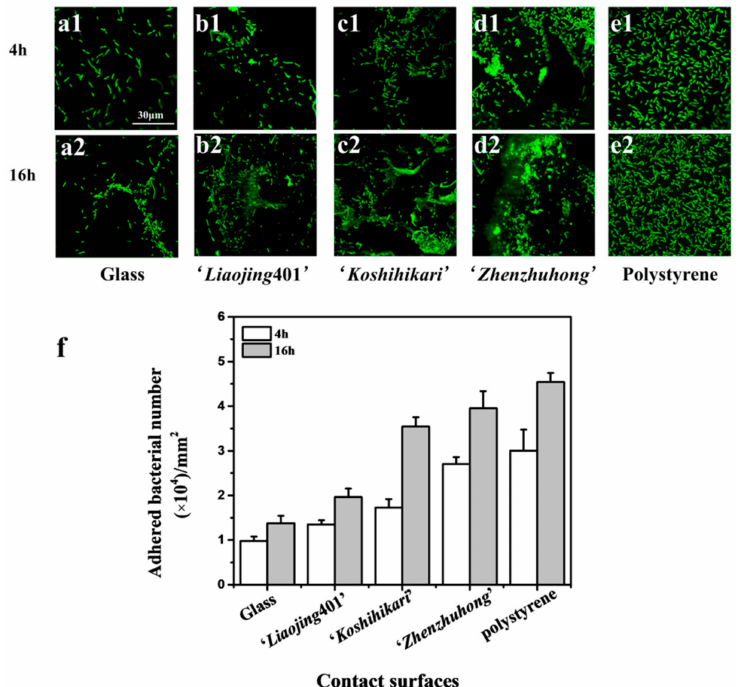
Figure 2. Laser confocal microscopy (CLSM) observation of the initial adhesion of JM2-gfp on the surfaces of glass, ‘ Liaojing 401’, ‘ Koshihikari ’, ‘ Zhenzhuhong ’ and polystyrene at 4 h ( a1 , b1 , c1 , d1 , e1 ) and 16 h ( a2 , b2 , c2 , d2 , e2 ). Quantitative analysis of JM2-gfp adhesion on di ff erent contact surfaces according to the fluorescence images ( f ). Error bars are shown as ±